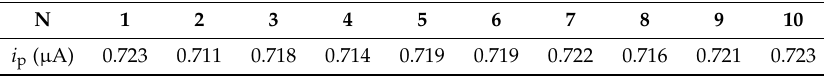
Table 2. i p of the RGO/CMC/Nafion modified GCE responding to the 1.0 ˆ 10 ´ 6 mol ¨ L ´ 1 of